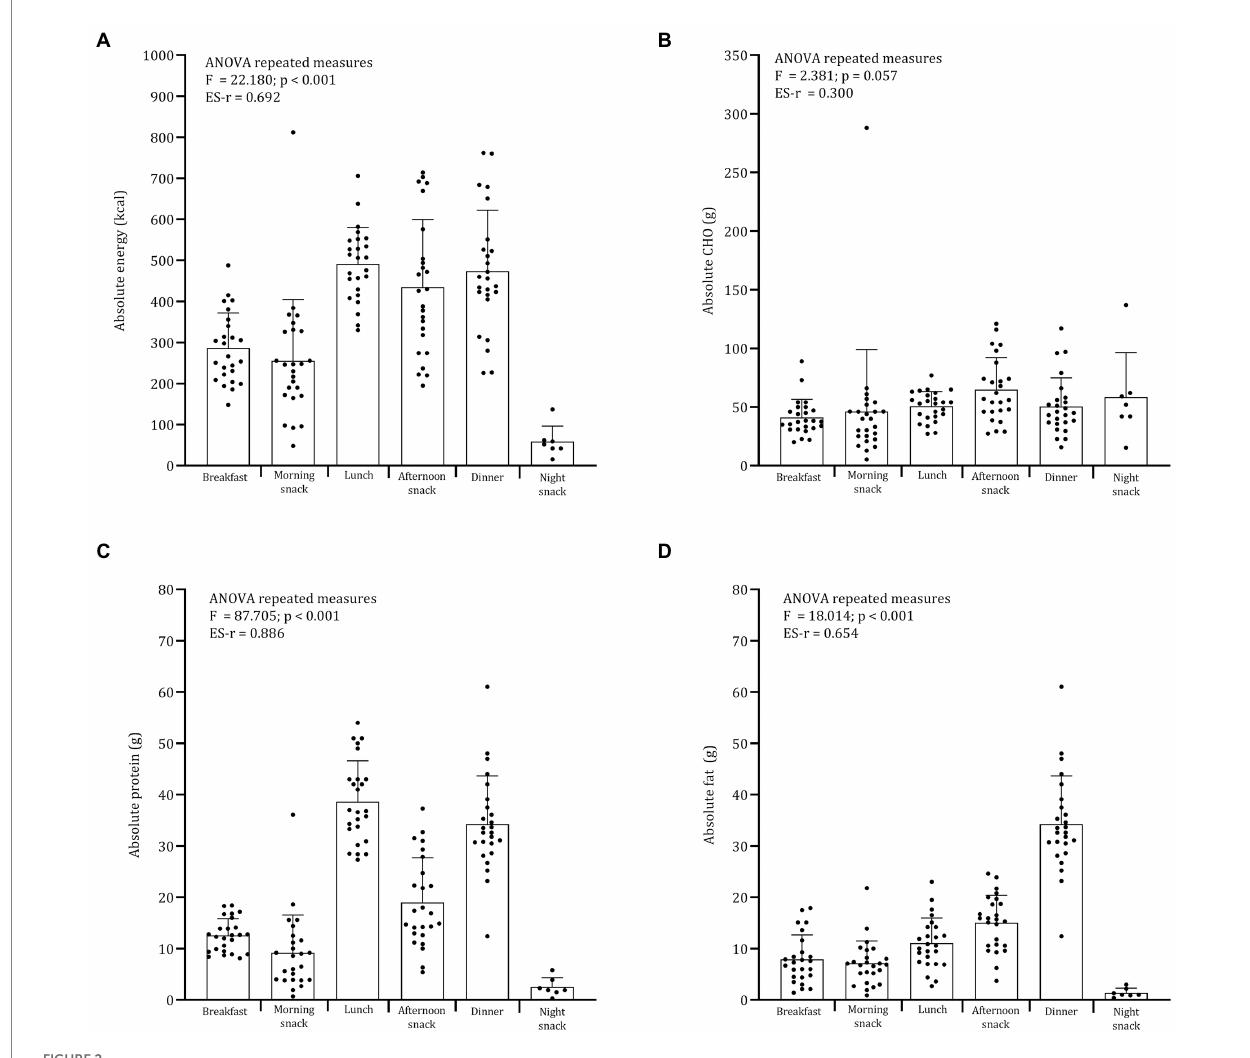
FIGURE 2 Daily distribution of absolute (A) energy, (B) CHO, (C) protein, and (D)